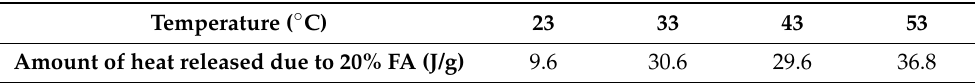
Table 5. The heat released due to 20% of siliceous fly ash at 165